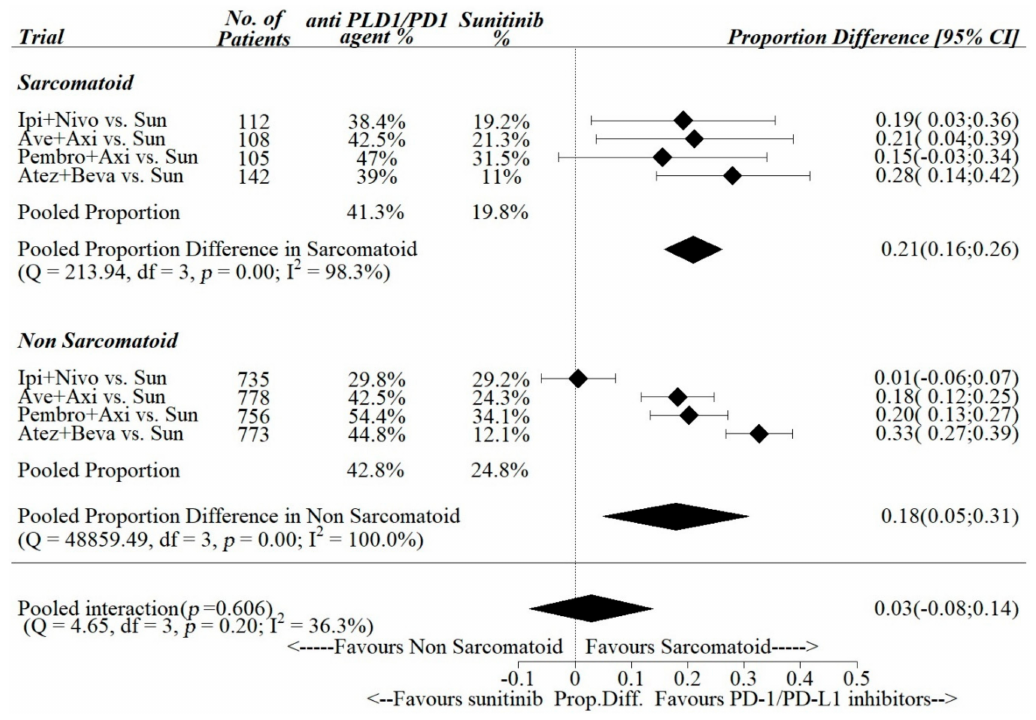
Figure 5. Interactions between complete response rate and sarcomatoid histology.